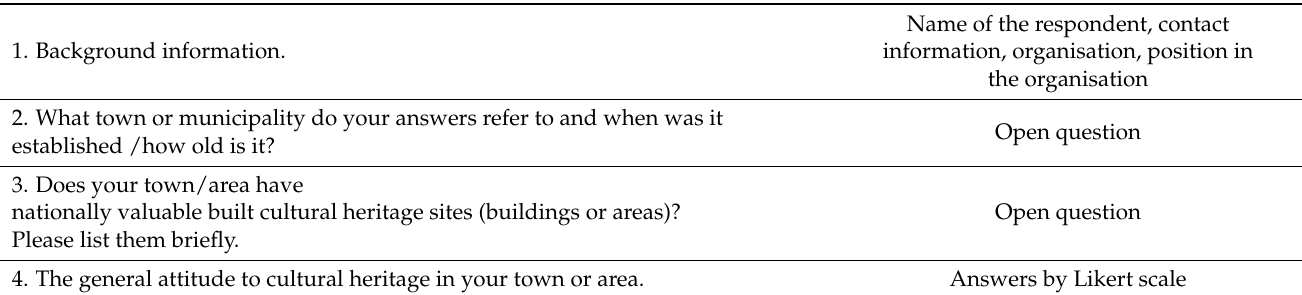
Table 2. List of the inquiry